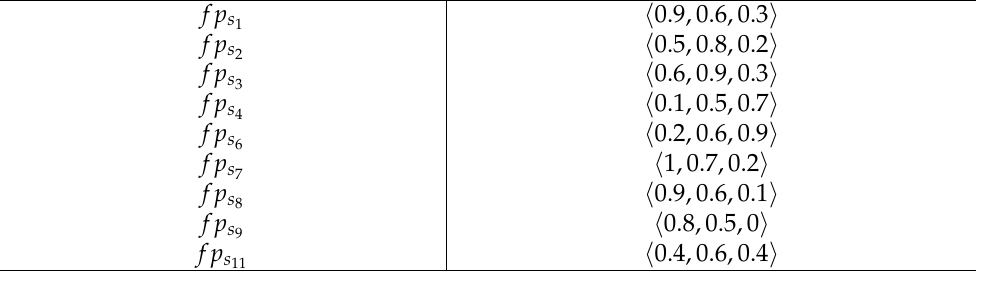
Table 2. Terminal